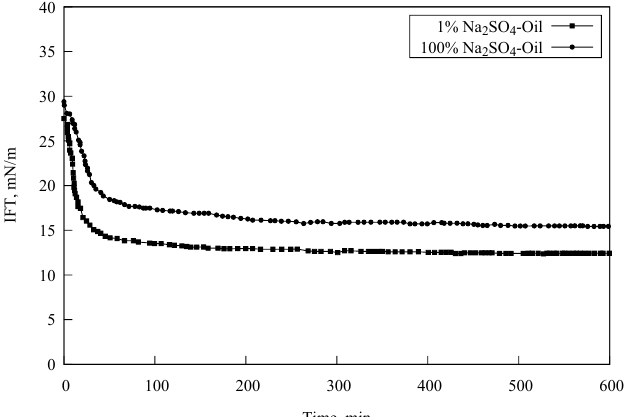
Figure 3. Interfacial tension of 1% Na 2 SO 4 with oil (plateau at 12.3 mN/m) and 100% Na 2 SO 4 with oil (plateau at 15.8 mN/m) .